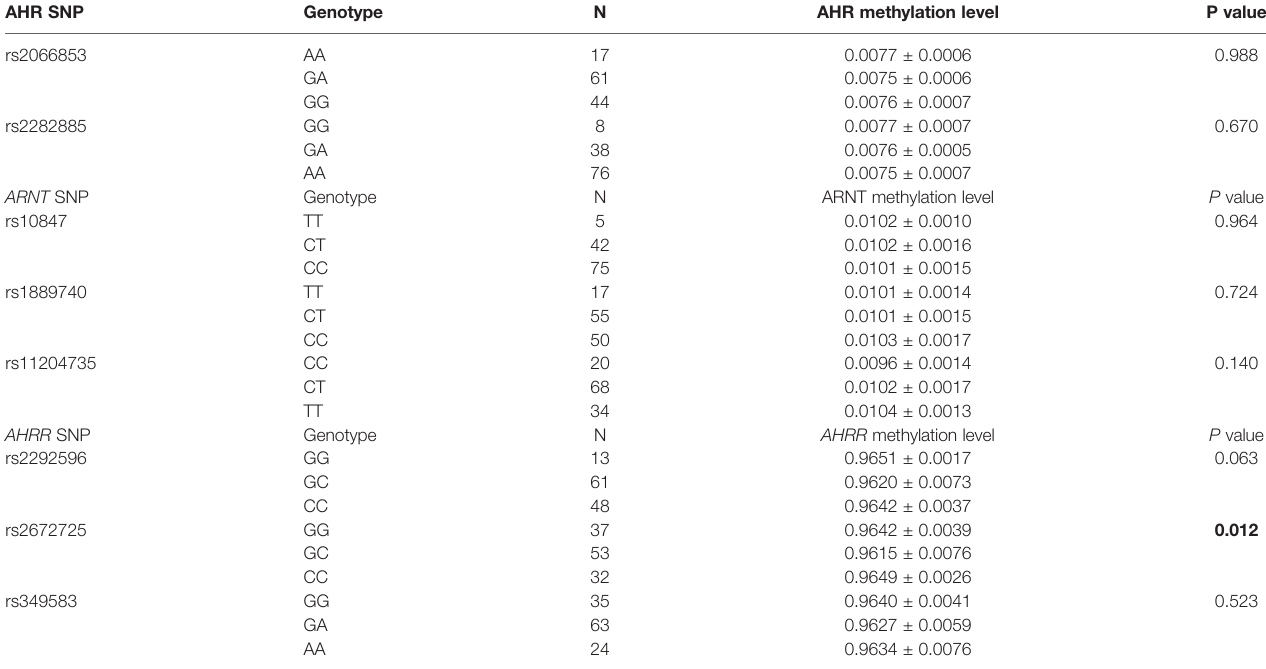
TABLE 7 | Associations between AHR , ARNT , AHRR genes polymorphisms with their methylation levels in RA patients. AHR